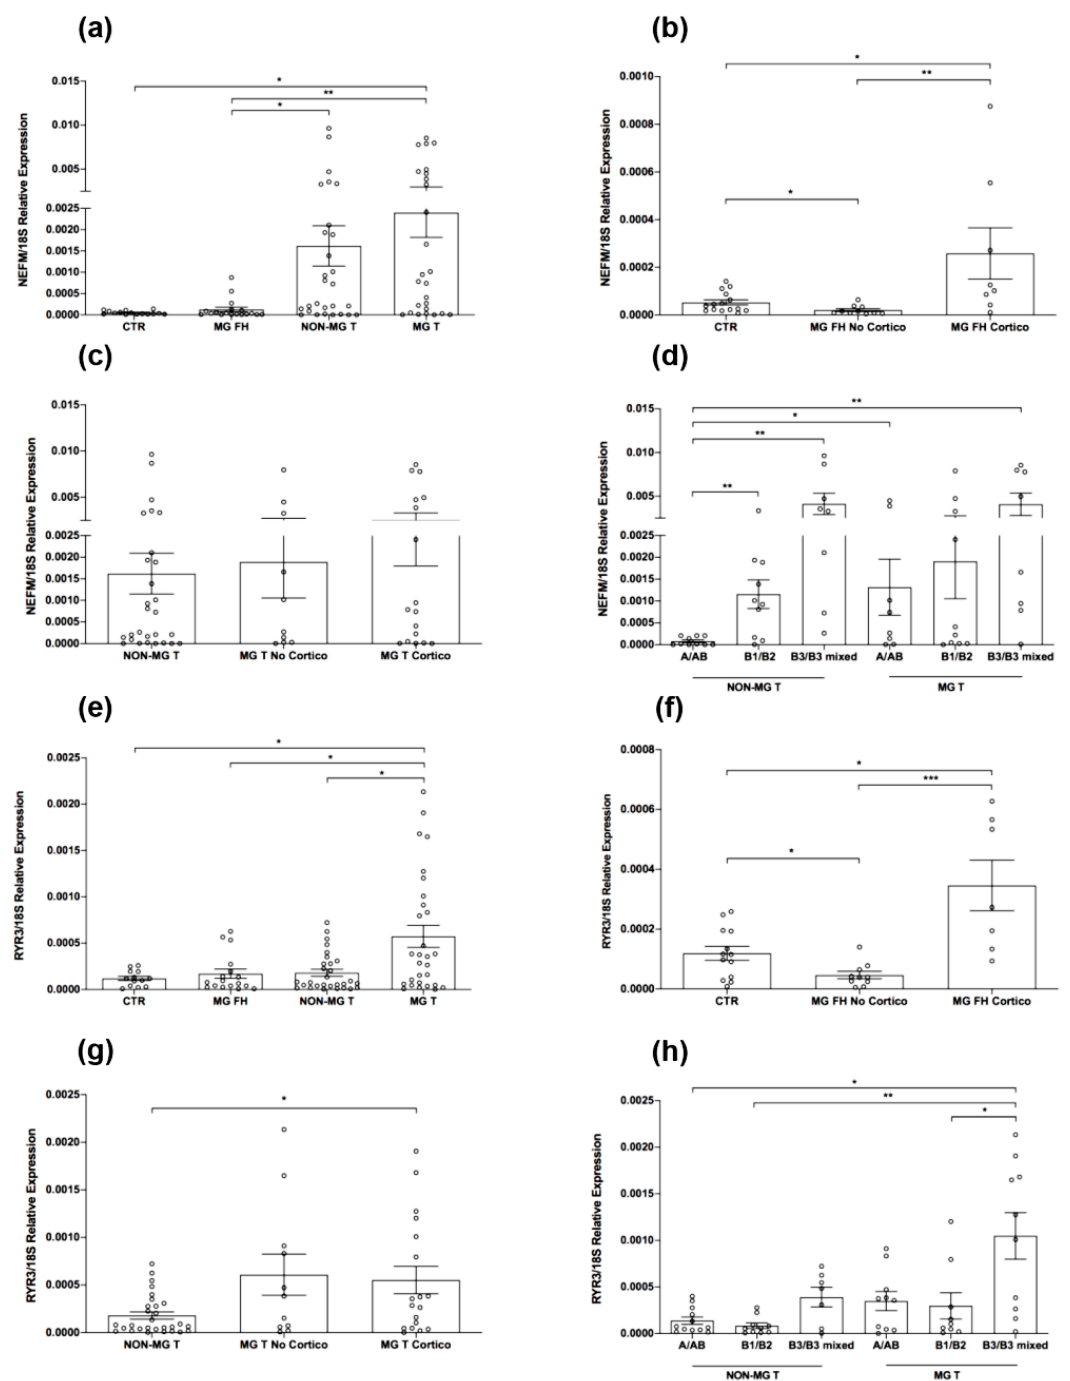
Figure 4. NEFM and RYR3 expression in MG and control thymuses. ( a – d ) NEFM mRNA levels in normal thymuses (CTR), follicular hyperplastic (MG FH) thymuses from MG patients stratified in corticosteroid-naïve (MG FH No Cortico) and -treated (MG FH Cortico), thymomas from non-MG patients (NON-MG T), thymomas (MG T) from MG patients stratified in corticosteroid-naïve (MG T No cortico) and -treated (MG T Cortico), and NON-MG T and MG T stratified according with WHO thymoma type. ( e – h ) RYR3 mRNA levels in CTR thymuses, MG FH from patients stratified in MG FH No Cortico and MG FH Cortico, NON-MG T and MG T from patients stratified in MG T No Cortico and MG T Cortico, and non-MG T and MG T stratified according with WHO thymoma type. In the graphs, gene expression levels were expressed as relative values (2 −Δ Ct × 100) that were normalized toward the endogenous 18S. Mann–Whitney test, * p < 0.05; ** p < 0.01; and *** p < 0.001.